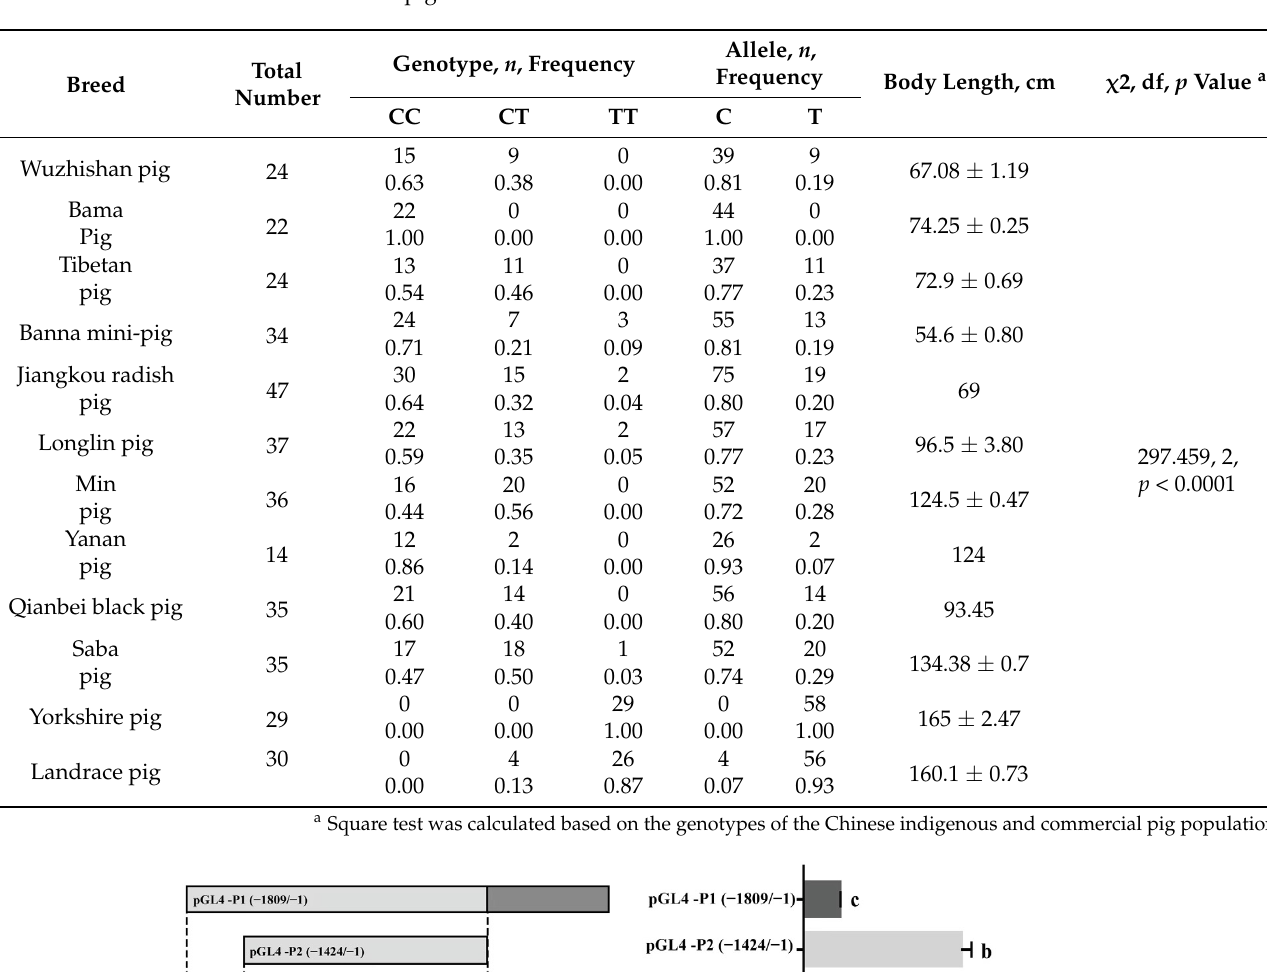
Table 1. Genotype and allele frequencies of the pig HHEX gene g.104194045T > C polymorphisms in different pig breeds.